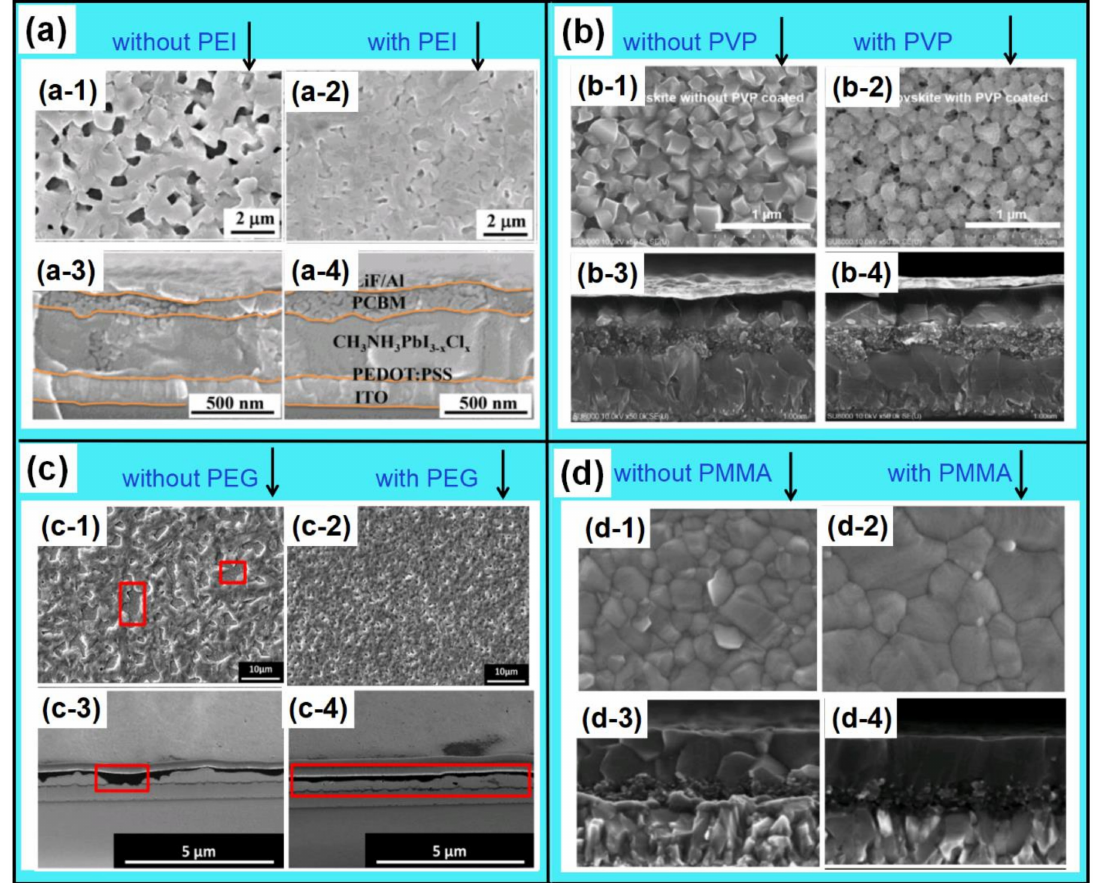
Figure 10. Comparisons of FESEM images and corresponding cross-sectional FESEM images of perovskite films with and without several di ff erent polymer additives: ( a ) PEI (reproduced from Reference [165] with permission, copyright The Royal Society of Chemistry, 2016), ( b ) PVP (reproduced from Reference [166] with permission, copyright Wiley, 2017), ( c ) PEG (reproduced from Reference [170] with permission, copyright American Chemical Society, 2015), and ( d ) PMMA (reproduced from Reference [173] with permission, copyright Nature Publishing Group, 2014),